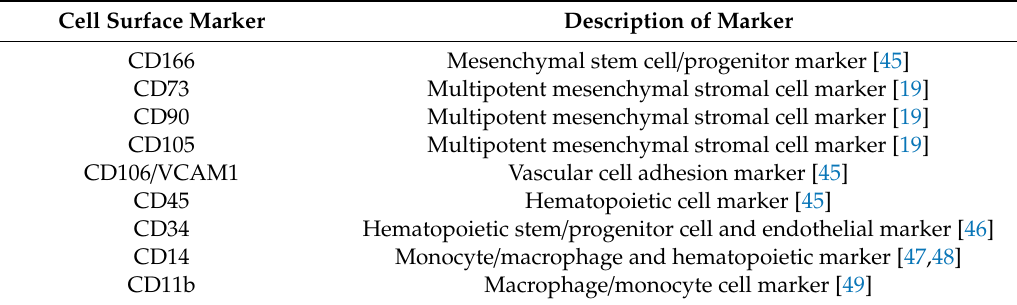
Table 2. Cell surface markers utilized for